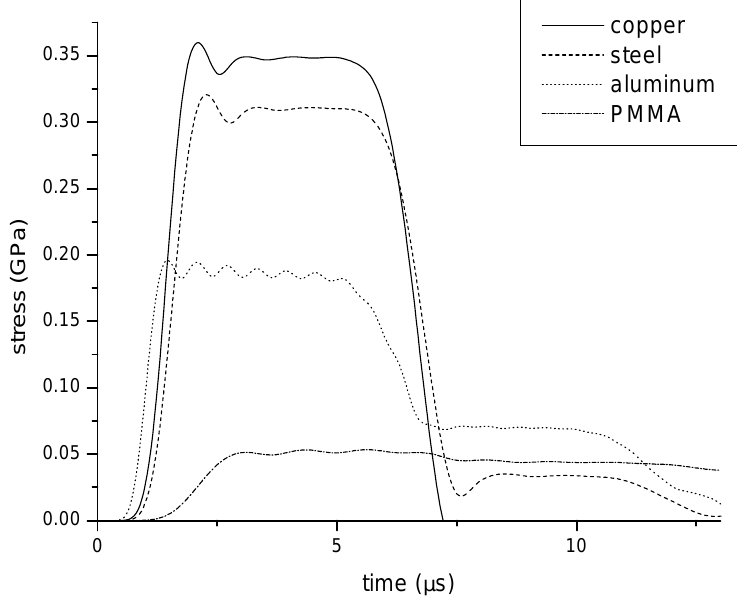
Fig. 4. Stress response in aluminum and PMMA target rod (Case